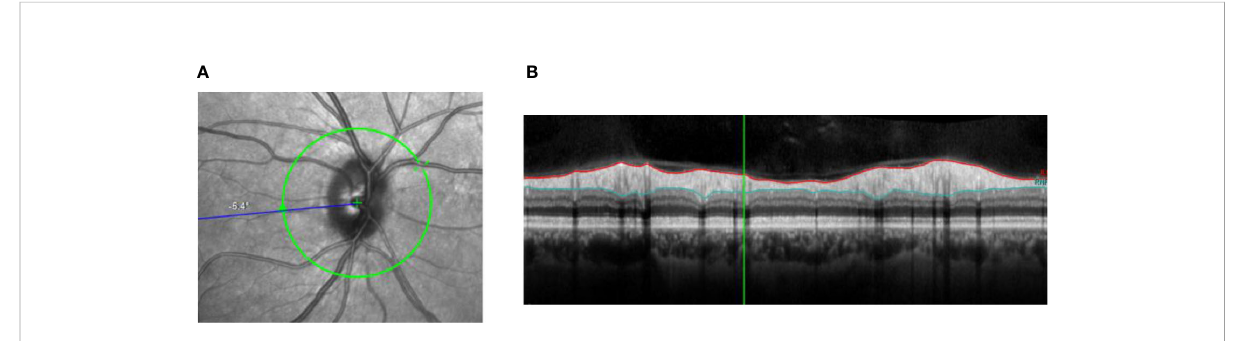
FIGURE 2.2 Peripapillary RNFL thickness. (A) Shows the location where the thickness of the RNFL can be determined around the optic nerve. Figure 2.2B shows the contours of the RNFL (red and light blue lines). (B) Shows the contours of the RNFL (red and light blue